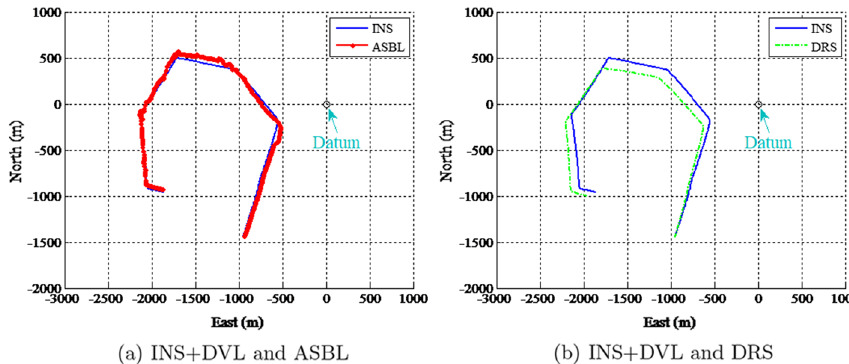
Fig. 12 Comparisons of INS